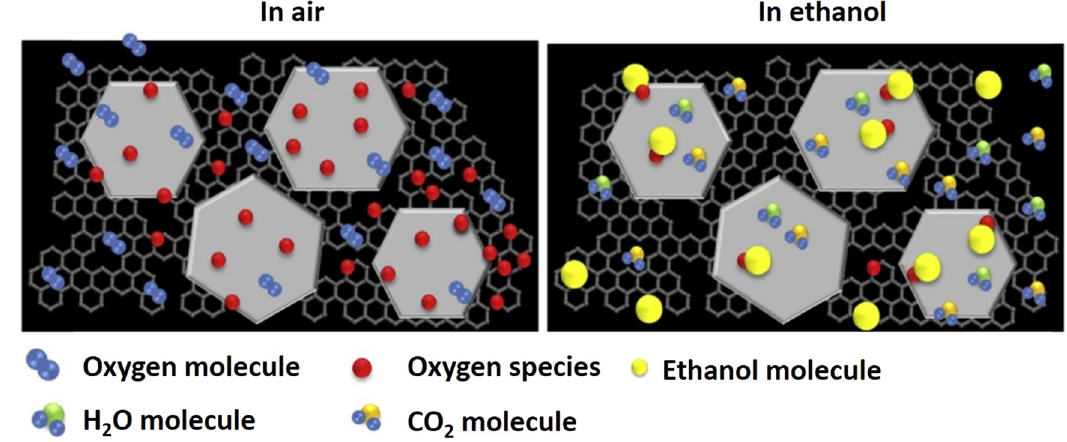
Figure 27: Schematic diagram of the sensing mechanism of rGO/MoO 3 to ethanol. Reproduced from ref. [ 173 ] .